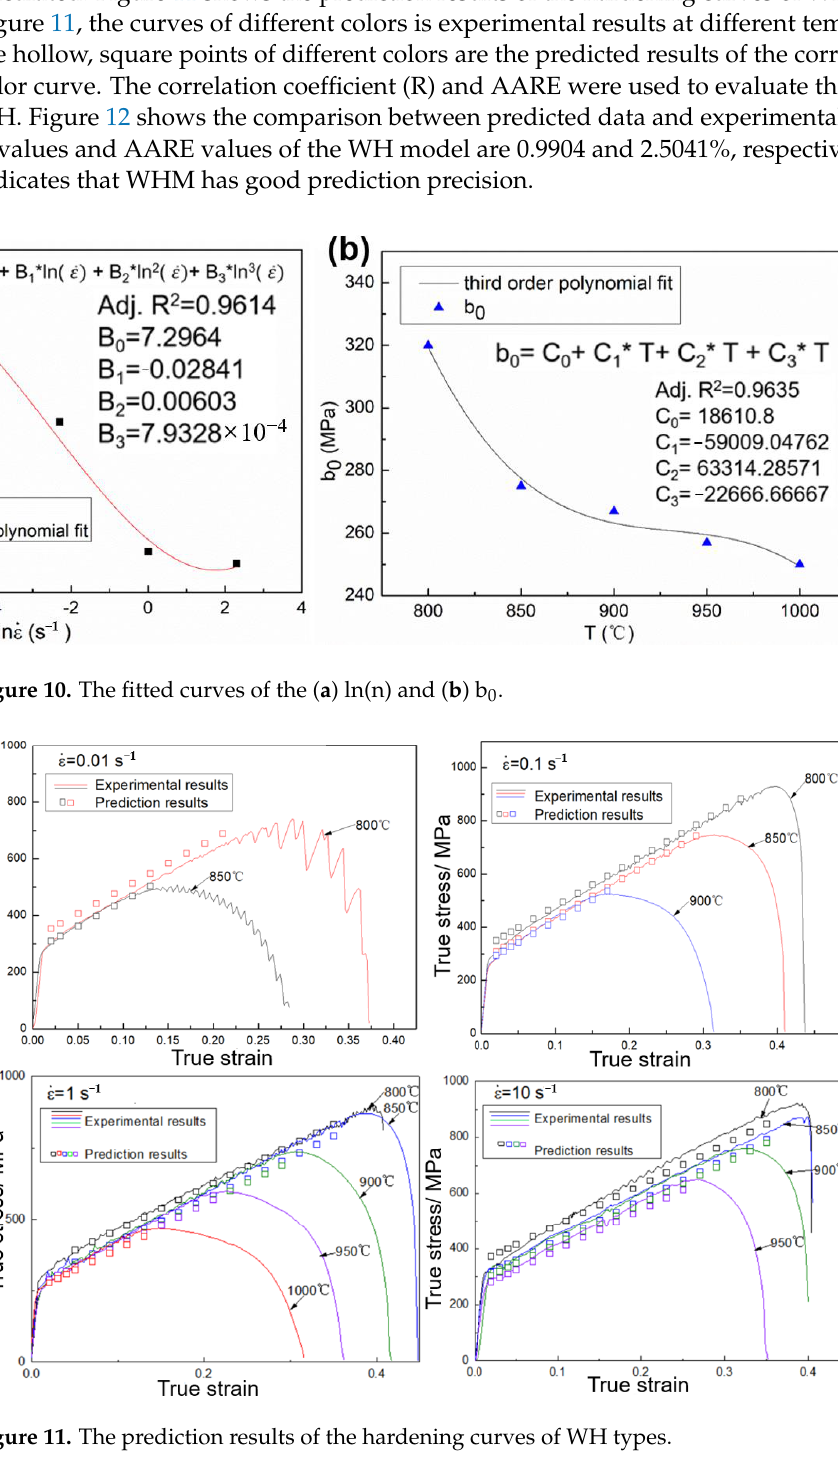
Figure 12. The comparison between the predicted data and the experimental data by WHM. The other flow curves, which include TDRV, DRV and DRX, can be described using the Arrhenius model, and its relevant mathematical expressions are as follows: 𝜀̇ = 𝐴[sinh(ασ)] 𝑛 exp [−𝑄 (𝑅𝑇)⁄ ] (8) 𝑍 = 𝜀̇exp [−𝑄 (𝑅𝑇)⁄ ] = 𝐴[sinh(ασ)] 𝑛